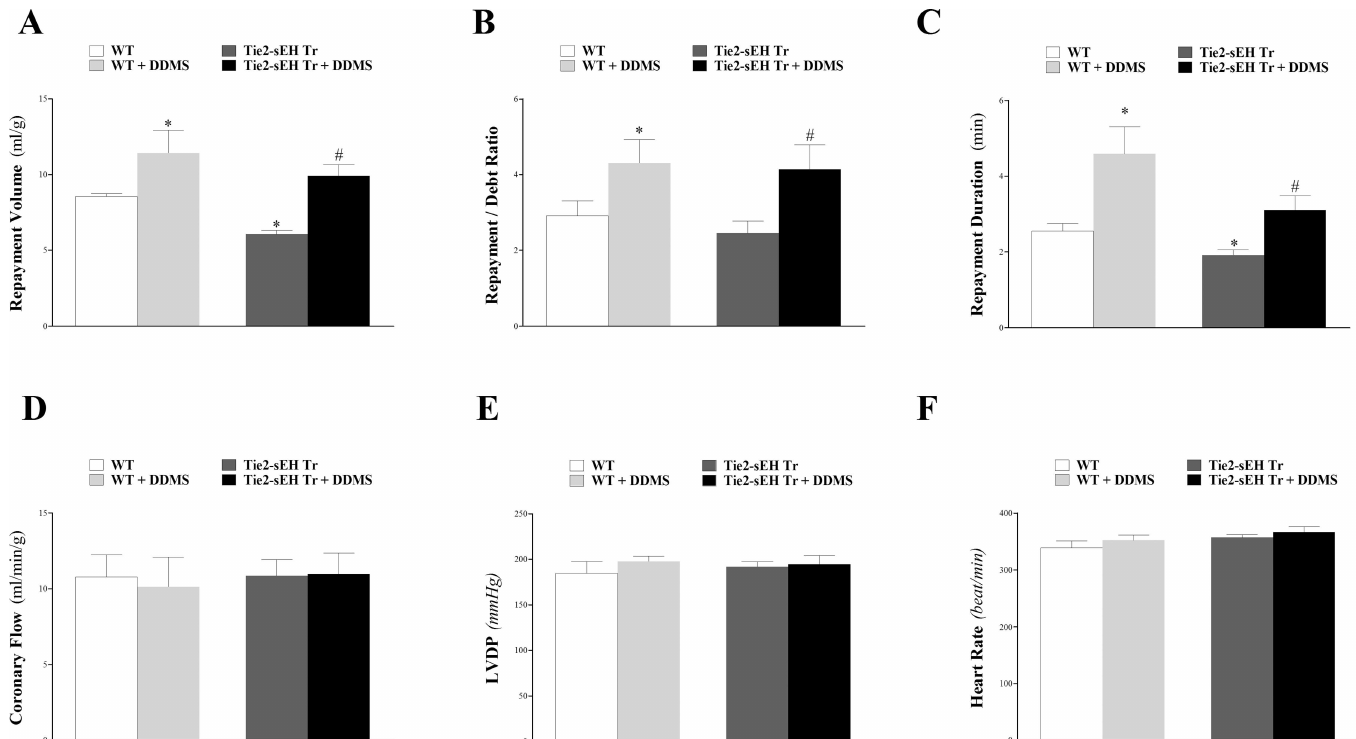
Fig 8. Effect of the CYP4A-blocker (DDMS, 1 μ M) on coronary reactivehyperemia (CRH) in Tie2-sEH Tr and WT mice. The CYP4A-blocker, DDMS, enhanced CRH in both Tie2-sEH Tr and WT mice. Repayment volume (A), repaymentduration(B), and repayment/debt ratio (C) were increasedin both strains. Repayment volume was decreased more in Tie2-sEH Tr compared to WT mice. BaselineCF (D), LVPD (E), and HR (F) were not different between the two groups. * P < 0.05 versus WT. # P < 0.05 versus DDMS–treatedWT. n = 8 per group.